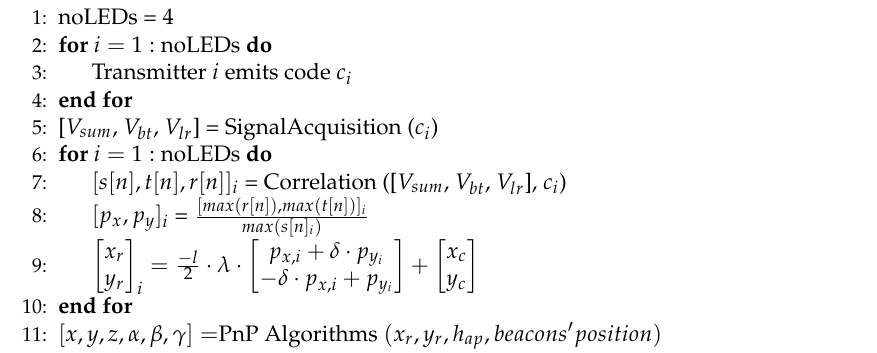
Algorithm 1 Positioning